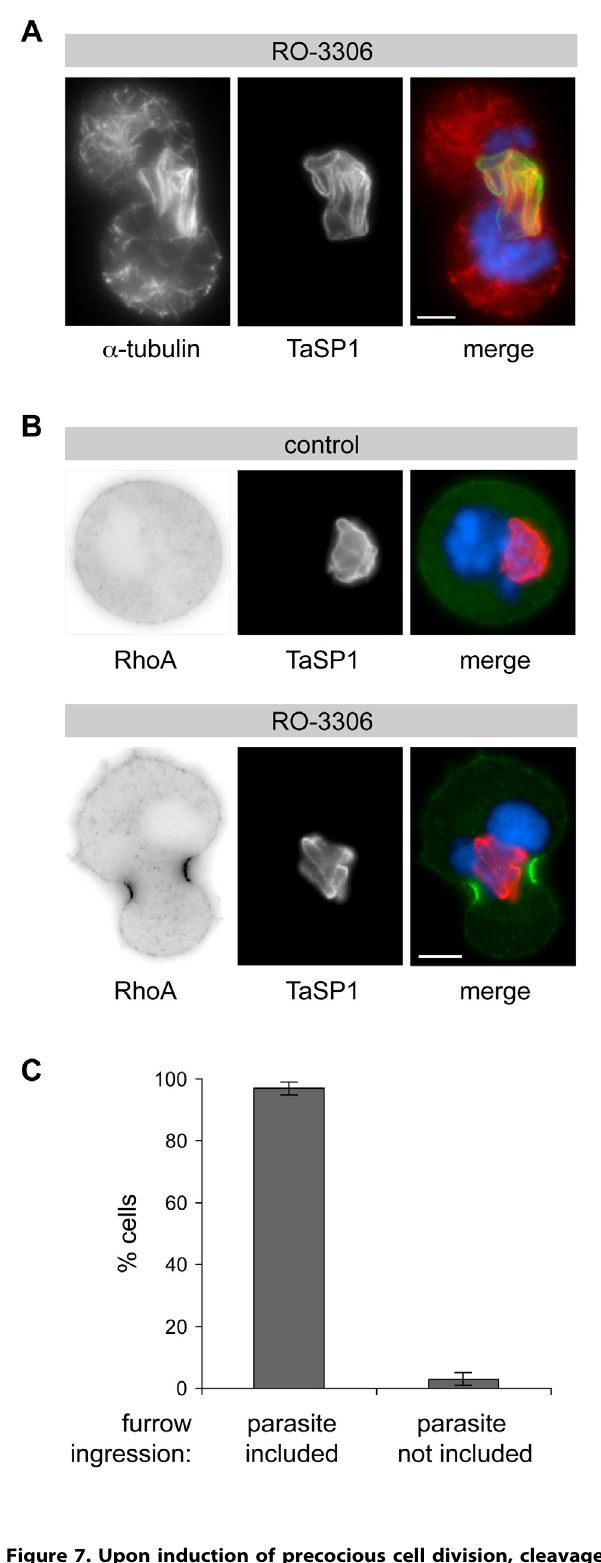
Figure 7. Upon induction of precocious cell division, cleavage furrows form in the immediate vicinity of the parasite. (A) T. annulata -transformed cells were synchronized in prometaphase by treatment with nocodazole. Upon nocodazole washout, precocious cell division was induced using RO-3306. After 20 min of treatment, newly formed microtubules were visualized by a -tubulin staining and